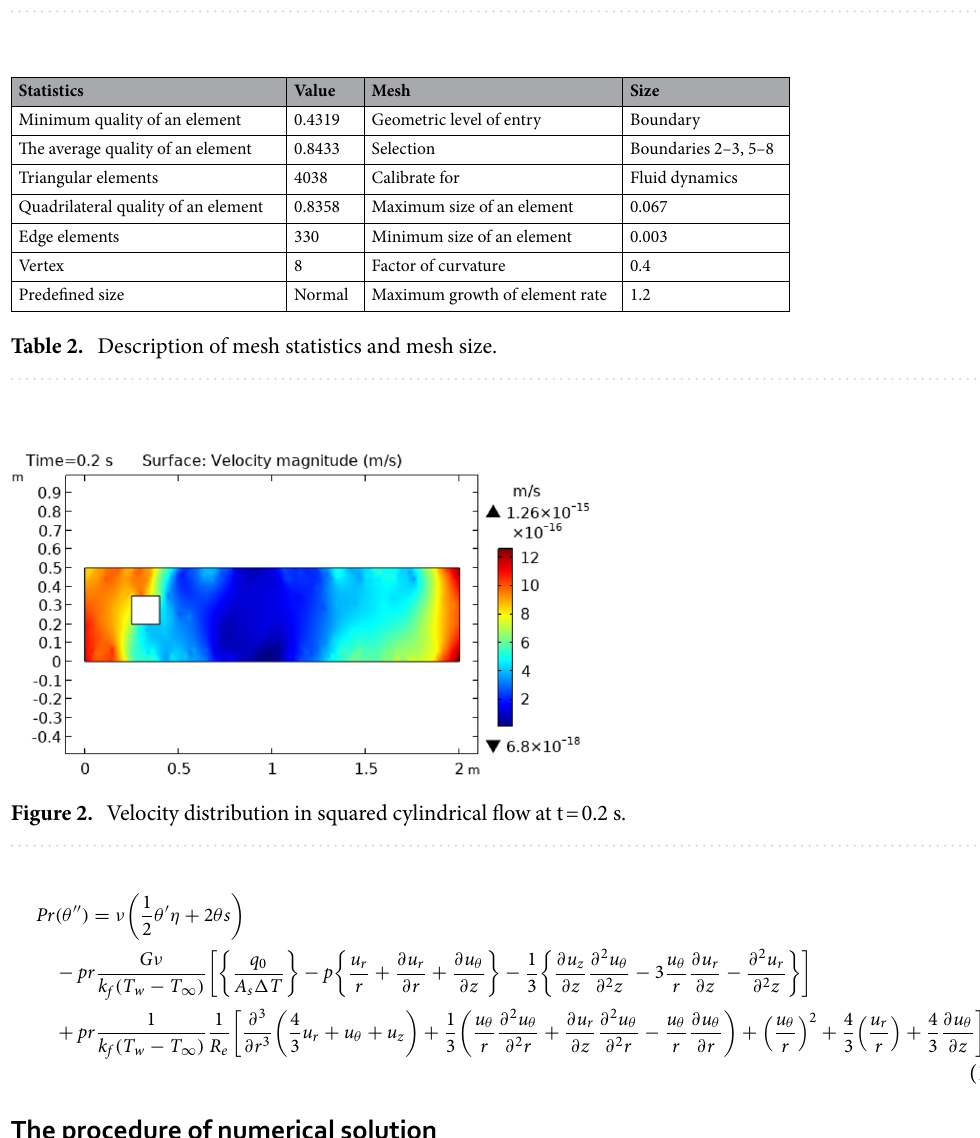
Table 1. The thermophysical properties of steam flow are as follow.